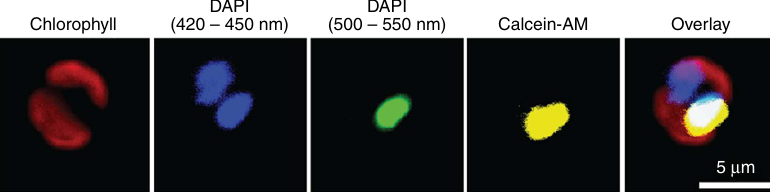
Figure 5 | Confocal fluorescence microscopy images of live E. huxleyi . Cells were dual-stained with DAPI and the membrane-permeable calcium stain calcein-AM. The emitted fluorescence in the wavelength window between 420 and 450nm originates from DAPI–DNA and DAPI–polyphosphate complexes, whereas the emission between 500 and 550nm originates from DAPI bound to polyphosphate. The red channel shows the auto-fluorescence of